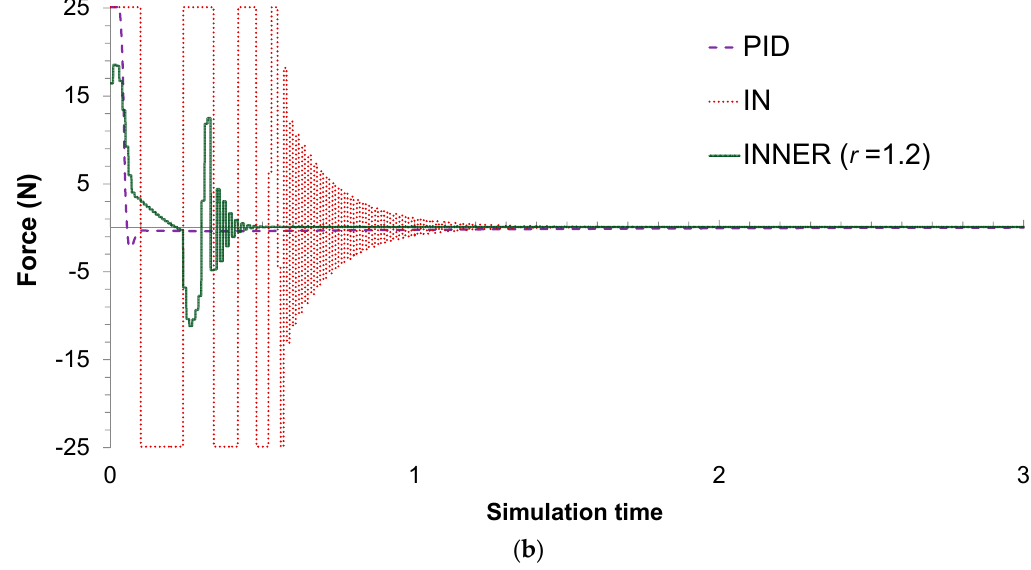
Figure 8. Inverted pendulum, ( a ) M = 1 kg: controller responses; ( b ) M = 1 kg: controller actions.